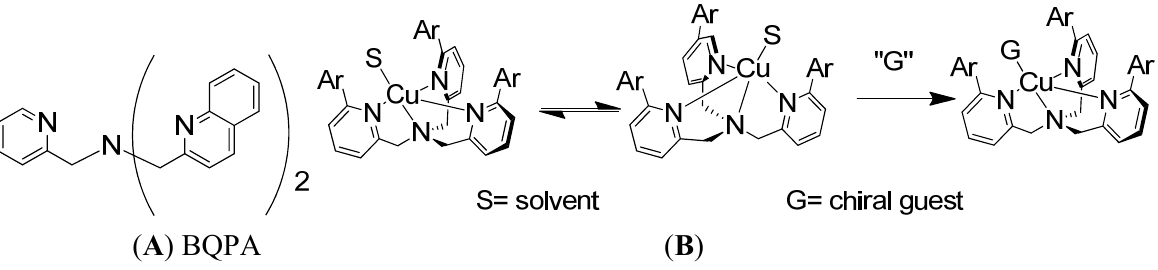
Figure 1. ( A ) Structure of BQPA. ( B ) Racemate Cu(II) complex of BQPA analogues